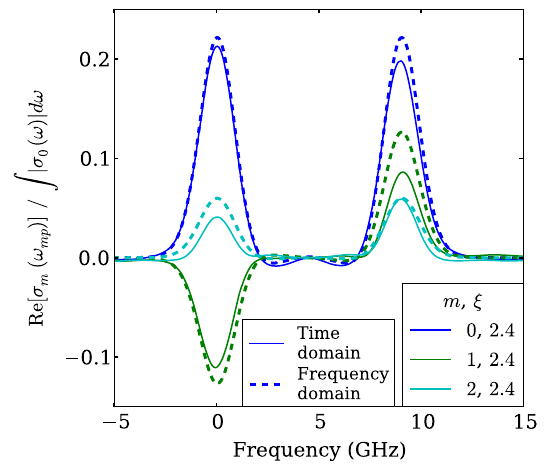
FIG. 10. Transverse bunch spectra for the lengthened Gaussian bunch case for the dominant mode at three different